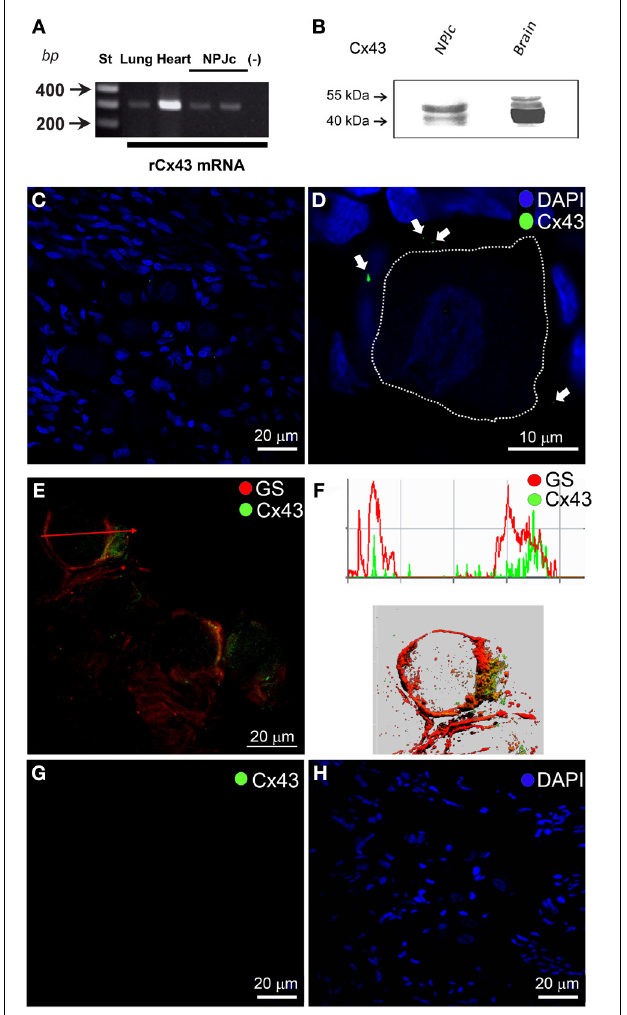
FIGURE 1 | Cx43 is expressed in NPJcs. (A) RT-PCR detection of Cx43 mRNA in total extracts of rat NPJcs. Each lane shows Etd + -stained amplicons: lanes 1 and 2, lung and heart used as positive controls, lanes 3 and 4 two independent NPJc samples and lane 5 a reaction performed without RNA (negative control) ( n = 4). (B) Levels of Cx43 in total NPJc homogenates were analyzed by Western blot. Cx43 was detected in total homogenates of NPJc and brain (50 μ g of protein). (C) Indirect immunofluorescence of Cx43 in a slice of NPJc. (D) Digital zoom of a single neuron soma, where white arrows indicate the presence of Cx43 and the neuronal soma was drawn with a white line. (E) Co-localization of Cx43 (green) and GS (red) was evident in a zone (NPJc edge) where both neuronal bodies and SGC are present. (F) Digital analyses of the fluorescence observed in (E) (Red arrow), and the Z-reconstruction of this fluorescent signal. (G) Indirect immunofluorescence in a slice of NPJc when Cx43 primary antibody was omitted. (H) DAPI staining shows cell nucleus of same slice as in panel (G) .